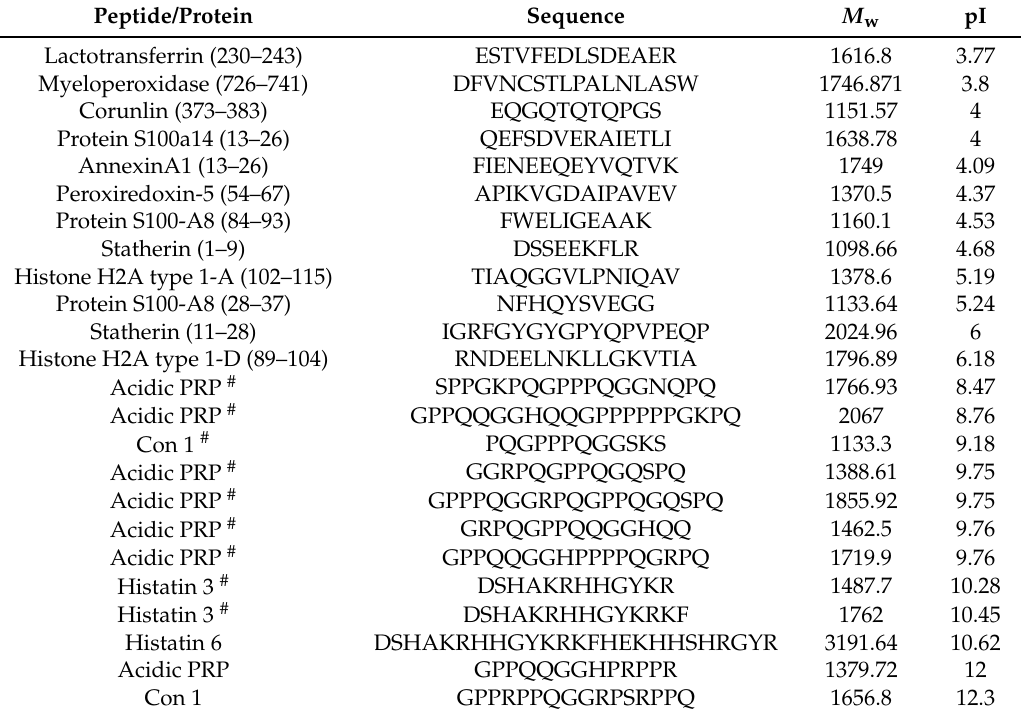
Table 2. A list of known peptides of human acquired enamel pellicle shown to bind CPP.